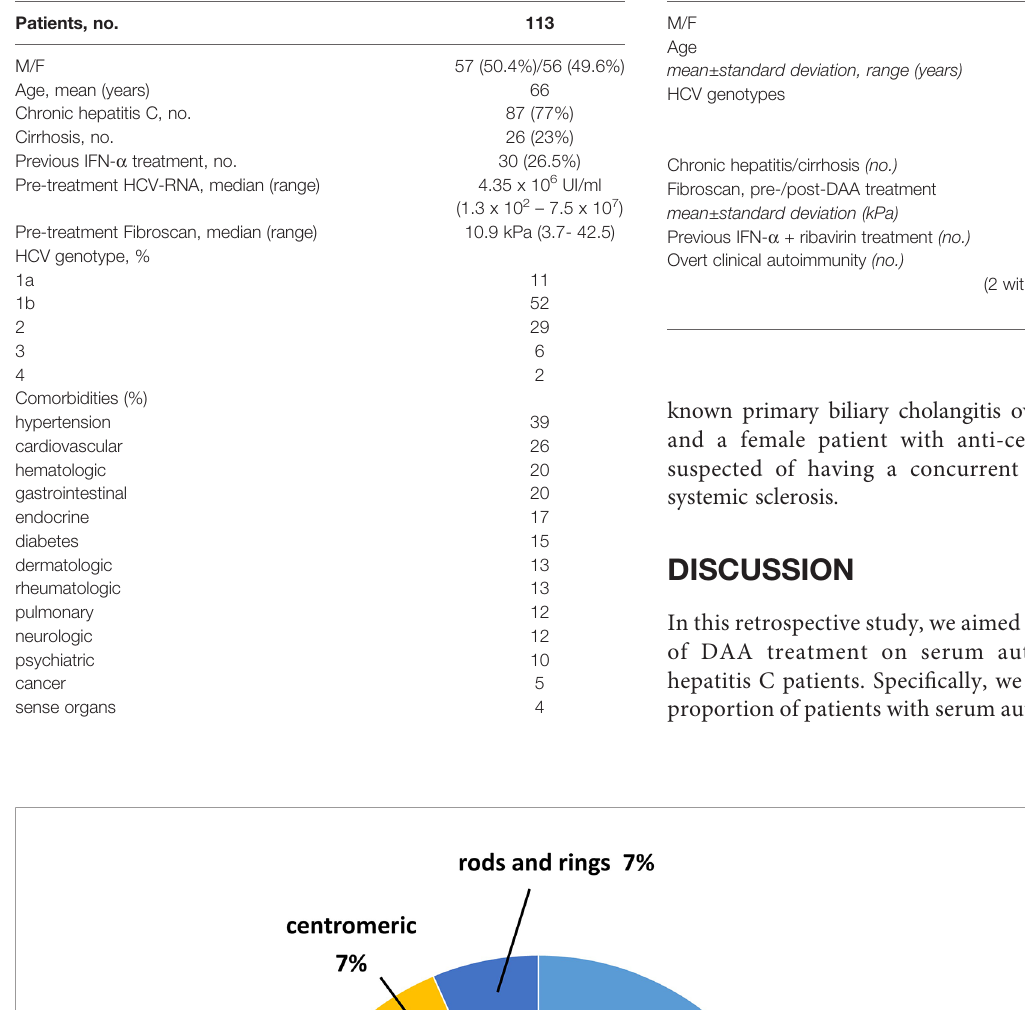
TABLE 2 | Characteristics of the 20 patients with pre- and post-DAA treatment autoantibody